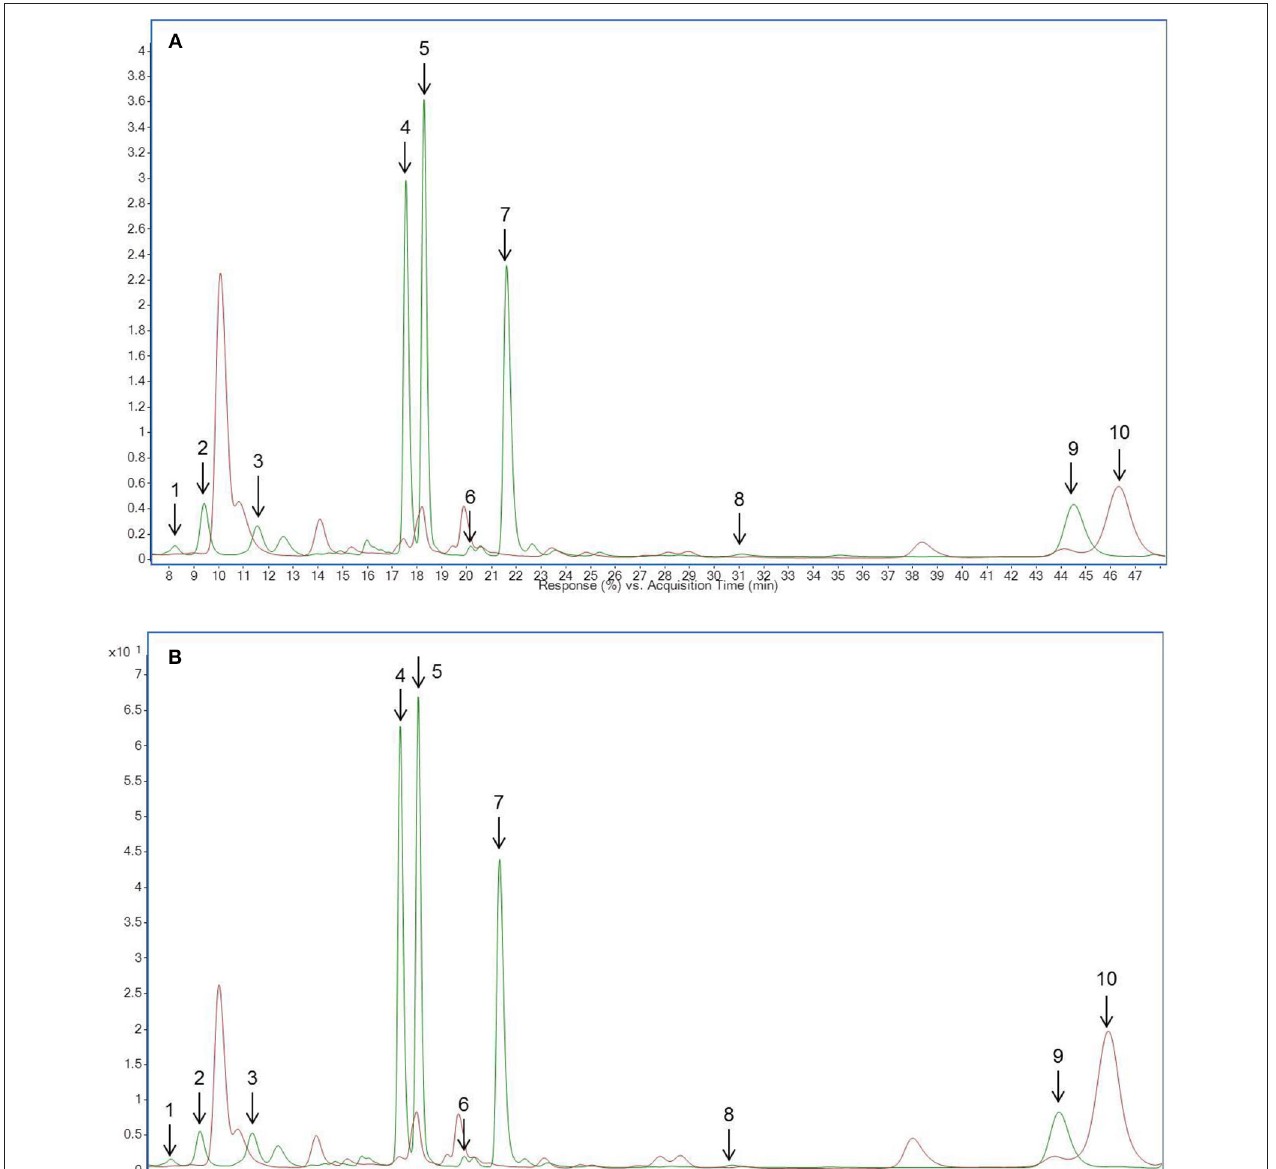
FIGURE 4 | HPLC chromatogram of carotenoid and chlorophyll metabolites in (A) pea microgreens (green) vs. pea microgreen bread (brown) and (B) pea leaves (green) vs. pea leaf bread (brown). Intensity in mAU, extract at 440nm. The bread contains 10.7% plant material, hence a dilution factor of 10.7% has to be taken